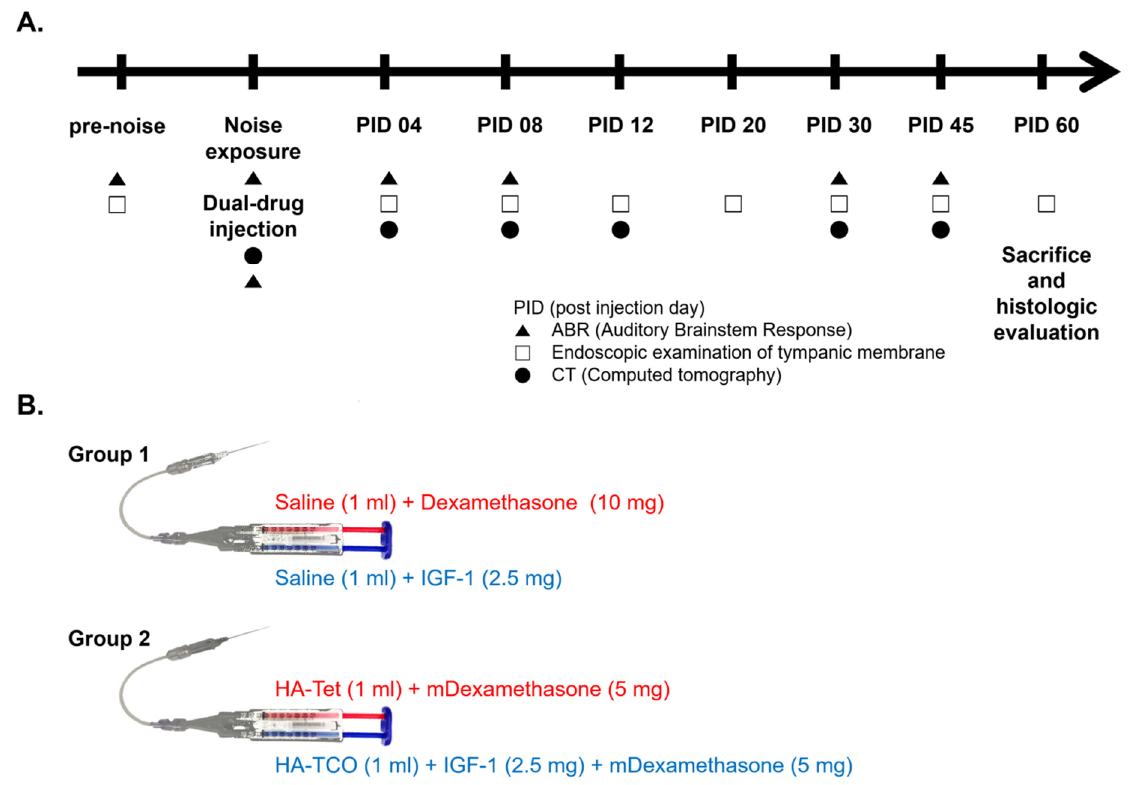
Figure 6. Schematic of experimental design and drug formulation. ( A ) Noise exposure and intra-tympanic injection of dexamethasone and insulin like growth factor 1 (IGF1) were performed on the same day; namely, post injection day (PID) 0. Auditory brainstem response (ABR) measurement, micro CT, and endoscopic examination of the tympanic membrane were performed every 4 to 15 days for 2 months. ( B ) Dexamethasone and IGF1 were used as drugs in groups 1 and 2. Saline and cross-linked HAs were the vehicles in group 1 group 2 respectively. HA-Tet, tetrazine-modified hyaluronic acid; HA-TCO, transcyclooctene-modified HA (HA-TCO).